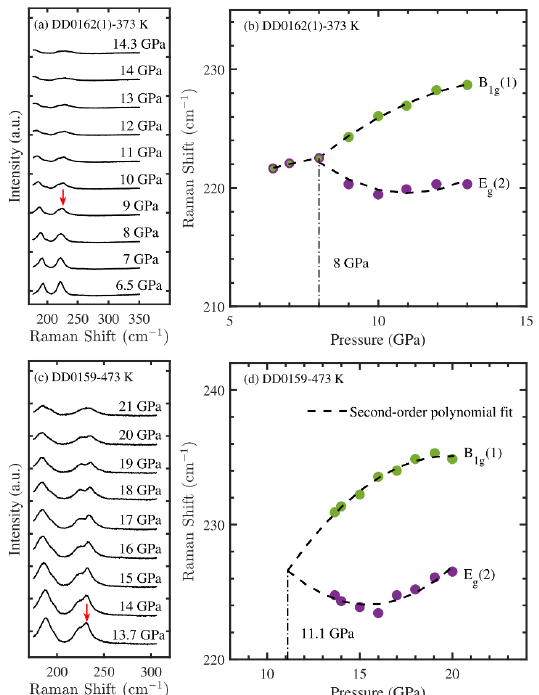
Figure 3. The characteristics of zircon Raman spectra at different pressures for ( a ) DD0079 and ( b ) DD0080. The red arrow in ( a ) represents the merger of the B 1g (1) and E g (2) modes into one peak, which splits into two peaks, as shown by the red arrow in ( b ). The blue arrow in ( b ) represents the split of the E g (1) mode into two peaks. ( c ) The Raman shift of the E g (1), B 1g (1), and E g (2) zircon modes as a function of pressure for DD0079 and DD0080. The vertical dashed lines correspond to the abrupt changes of 𝑑𝜔 / 𝑑𝑃 of the E g (1) and E g (2) modes.